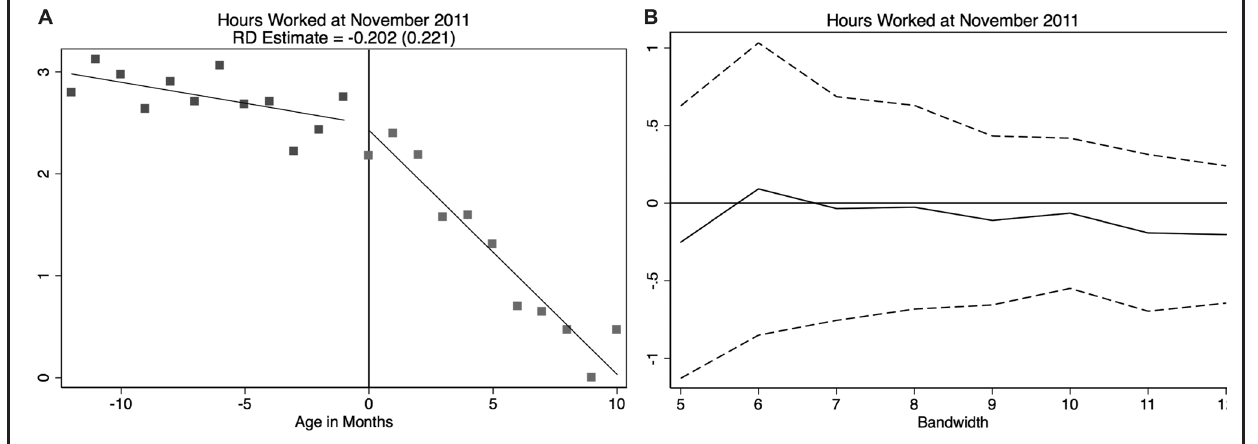
Average number of hours worked by the mother as of November 2011. (A) Each data point corresponds to the average value of each outcome by month of birth of the child in 1-month bins. The window in- cludes all children born to mothers from January 2010 until November 2011. The vertical line denotes the PPL cutoff of January 1 2011, normalized to 0. (B) The equivalent coefficient estimates and associ- ated 95% confidence intervals when equation 1 is estimated using 3, 4, ..., 12 month-of-birth cohorts on either side of the